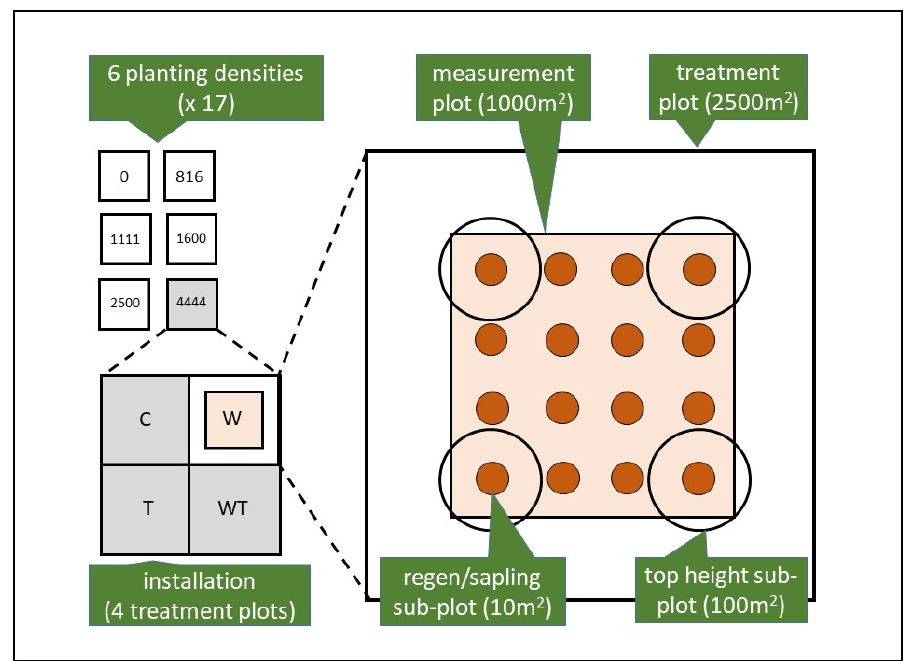
Figure 2. Arrangement of treatments and sample plots within installations. Installations were planted at one of 6 target densities and split into 4 treatment plots, each of which was sampled by a series of sub-plots.